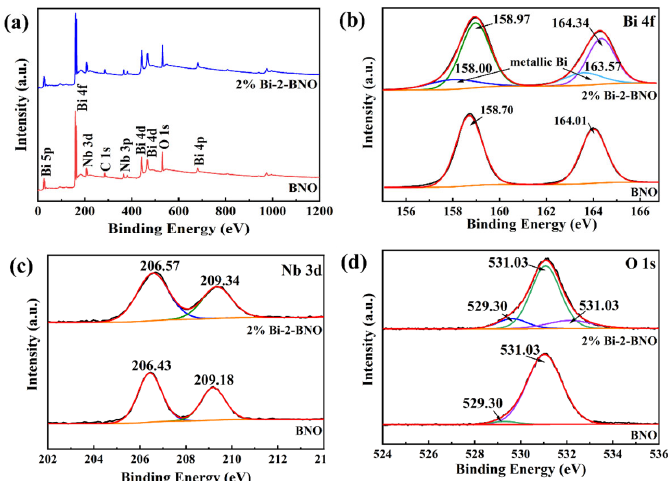
Figure 8. XPS analysis of the BNO and 2%Bi ‐ 2 ‐ BNO samples: ( a ) survey spectra, ( b ) Bi 4f, ( c ) Nb 3d and ( d ) O 1s.